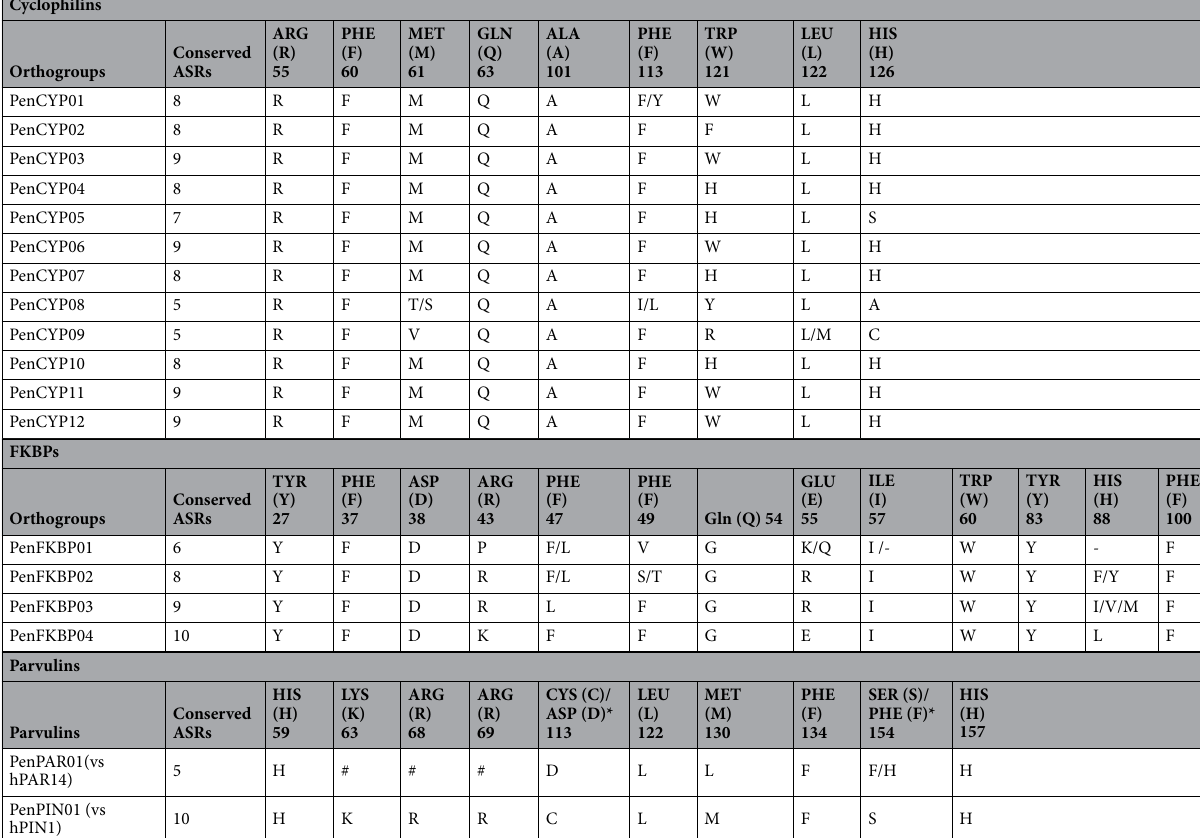
Table 4. Conservation of the active site residues with respect to the human orthologues hCYPA, hFKBP12 and hPIN1/hPAR14, respectively, in the cyclophilins, FK506-binding proteins (FKBPs) and parvulins of different orthogroups in different Penicillium spp. *: residues present in hPAR14; #: residues absent in